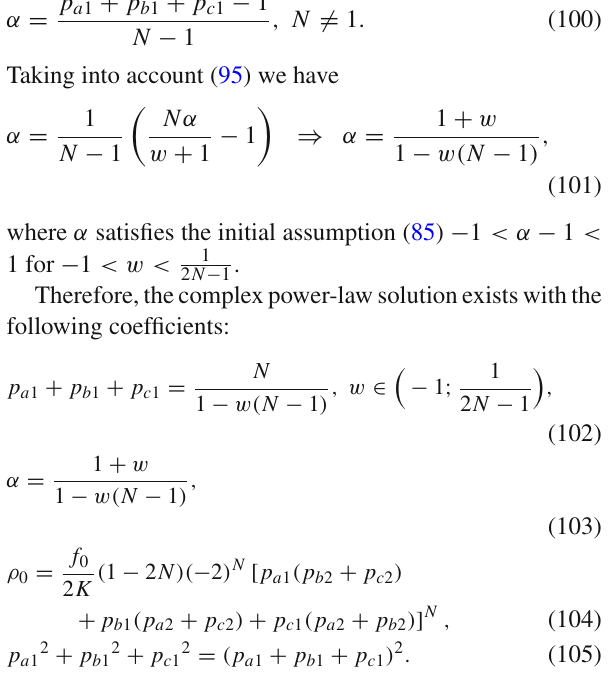
for the left picture, 12